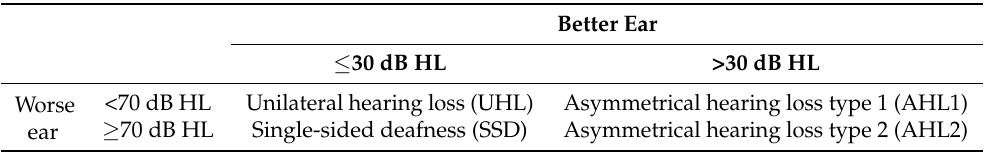
Table 1. Audiological criteria for the classification of AHL into three subgroups based on the PTA4. This study included only cases with an interaural difference of 15 dB HL or greater in the four- frequency (0.5, 1, 2 and 4 kHz) pure-tone average thresholds.